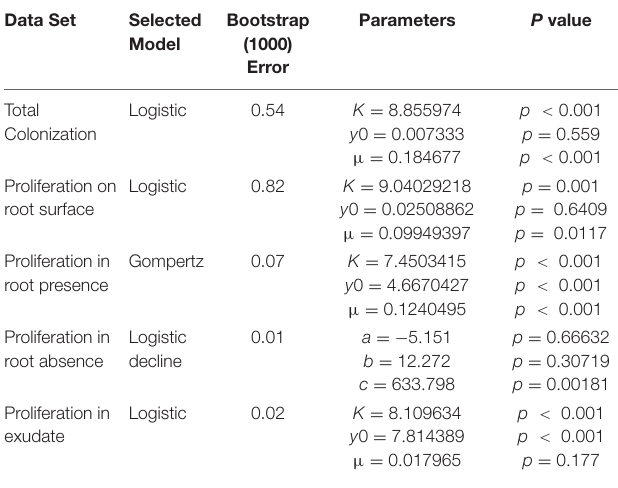
TABLE 2 | Models selected based on AIC value for each data set along with model